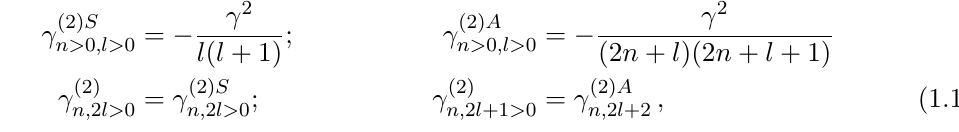
Figure 1 . Deformations of the generalized free field (GFF) CFTs in the wave function CFTs (down) and cosmological correlator CFT (up). O S [ O ] and [ O ] (see section 1 O 1 n,l 2 O 2 n,l